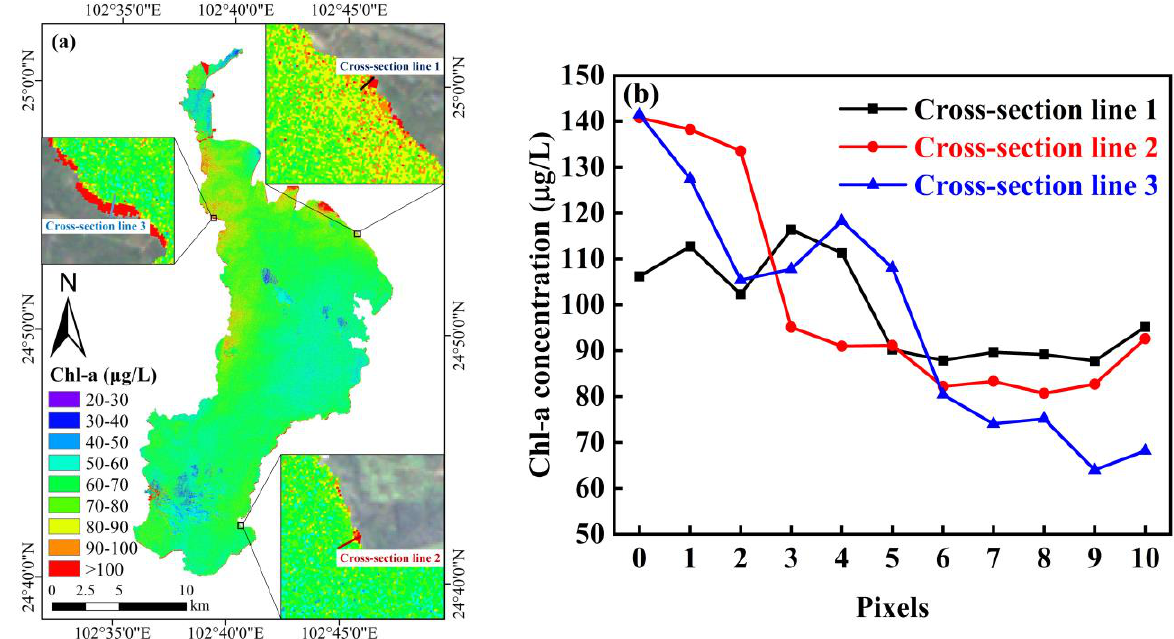
Figure 5. Spatial patterns of derived Chl-a concentration in Dianchi Lake on April 2, 2019. ( a ) describes the spatial distribution of Chl-a concentration in Dianchi Lake. ( b ) is the three cross-sections randomly selected in ( a ) to quantitatively express the variation of Chl-a concentration with the distance from the lakeshore.